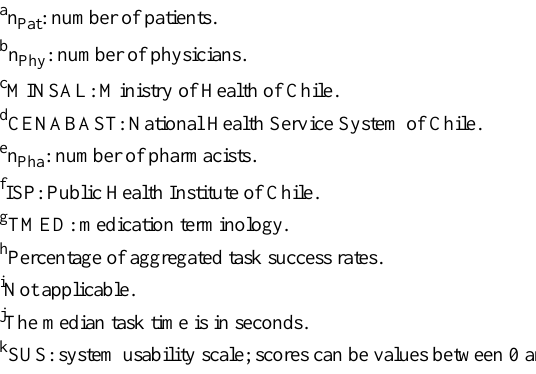
=18)Salcobrand TMED g (n Pat =15, =19)ISP f (n Pha =28)CENABAST d =20)MINSAL c (n Pat =44, (n Pat =15, n Phy =23, (n Phae n Phy n n Pha